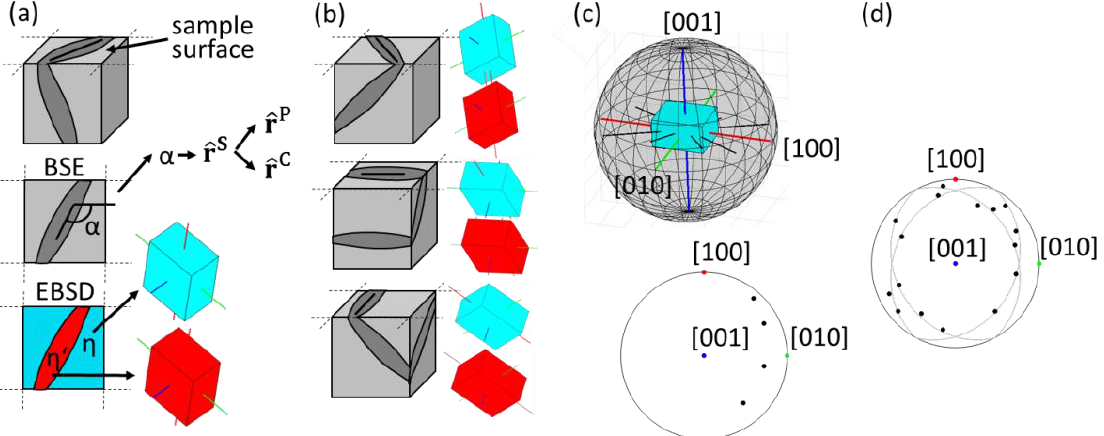
Figure 6. Schematic illustration of the procedure of determining the habit plane of a microstructural feature from metallographic cross sections and EBSD data. ( a ) Traces ˆ r of plate-like precipitate on the sample surface which is available for the microscopic investigation. The position of the trace in terms of α and the crystallographic orientation are, thus, determined. ( b ) Traces ˆ r S for various orientations of the sample with respect to the sample surface should be detected. ( c ) The measured traces ˆ r S expressed as [ uvw ] lie within the habit plane { hkl } and appear as big circles in a stereographic projection. For illustration purposes the four traces from ( a , b ) belonging to a specific habit plane ( hkl ) are shown. ( d ) Usually, measured traces belong to all habit planes, be they crystallographically equivalent or different. As an illustration of this, traces and corresponding big circles are shown for four equivalent habit planes of the orthorhombic crystal structure of the η phase. The big circles of the habit planes are shown as gray lines in the stereographic projection.